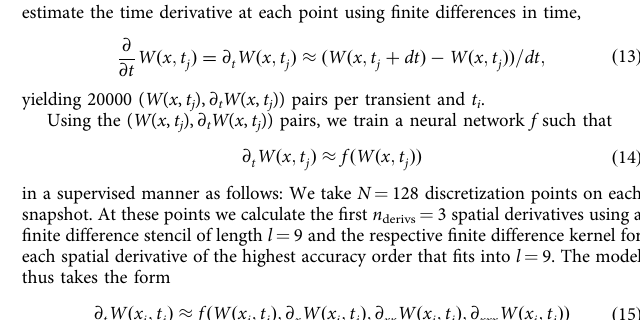
We integrate both of these snapshots forward in time for T = 20 time units, and sample data after each dt = 10 − 3 . This results in two transients, each comprised of 20,001 snapshots at each t i . This means, in total there are 2× 20,000 × 20 = 8 ⋅ 10 5 snapshot data pairs for training, and 2 ×20,000 for validation. We subsequently downsample the data to N = 128 points per snapshot. In order to fi nd a parametrization for the discretization points of the PDE, we concatenate the training time series of the N = 128 points, resulting in 2× 20000× 20 long trajectories. Then, we use diffusion maps with an Euclidean distance and a Gaussian kernel, and take the kernel scale ϵ as the median of all squared distances. This results in the one-dimensional parametrization ϕ 1 , as shown in Fig. 6(c). We resample data on a regular grid in the interval (cid:2) 1 ; 1 ½